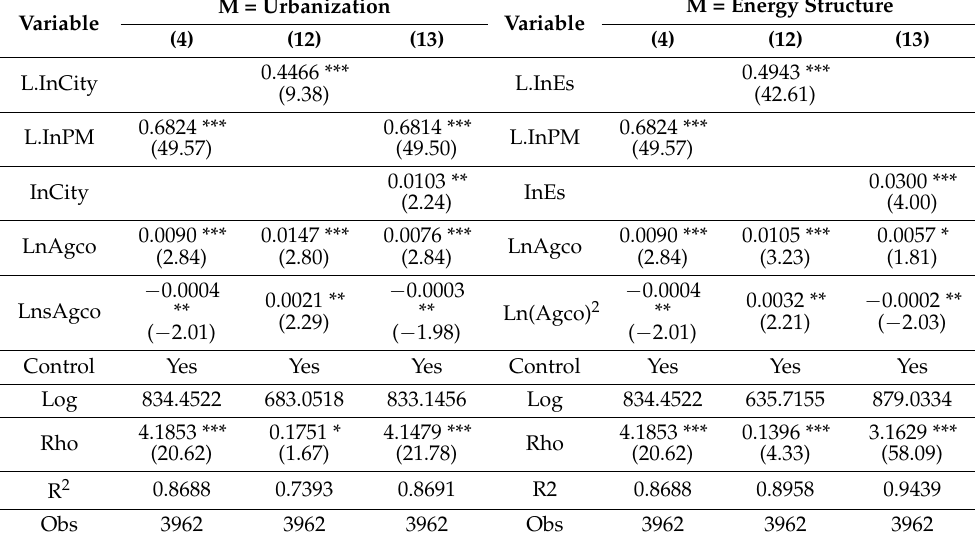
Table 7. Mediating Effect Tests Based on Urbanization and Energy